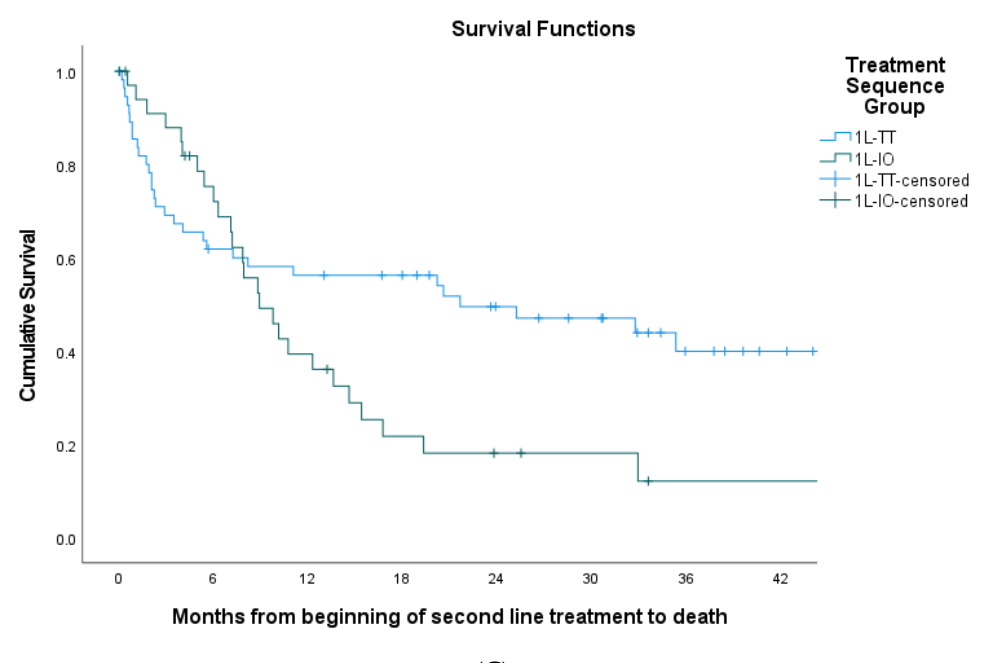
Figure 1. Survival outcomes of BRAF V600-mutant population ( n = 186). ( A ) Overall survival of BRAF-mutant melanoma patients as per 1L-IO vs. 1L-TT Group (19.3 vs. 13.9 months, p = 0.459); ( B ) Overall Survival of BRAF-Mutant Melanoma Patients as per ‘1L-IO only’ vs. ‘1L-TT to 2L-IO’ vs. ‘1L-IO to 2L-TT’ vs. ‘1L-TT only’ (32.2 vs. 38.34 vs. 16.9 vs. 6.3, p < 0.001); ( C ) Survival from second-line treatment to time of death/last follow up in BRAF-mutant melanoma patients as per 1L-IO vs. 1L-TT group (8.9 vs. 21.7 months, p = 0.053). Therapy sequence lost its clinically meaningful OS improvement when potential con- Table 3. Multivariable Cox analysis of study founders were accounted for in our multivariable Cox analysis (HR 0.838, 95%CI 0.502– 1.400, p = 0.500). Instead, number of metastatic sites > 2 (HR 2.195, 95%CI 1.302–3.699, p = 0.003), baseline brain metastasis (HR 1.833, 95%CI 1.073–3.130, p = 0.027), and baseline ECOG ≥ 2 (HR 3.957, 95%CI 2.226–7.034, p < 0.001) were significantly associated with